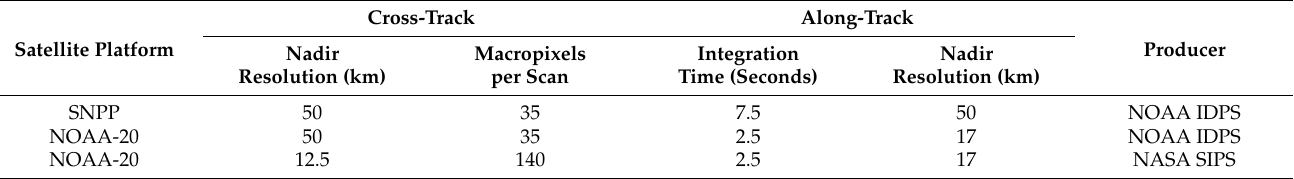
Table 1. OMPS-NM SDR datasets with different spatial